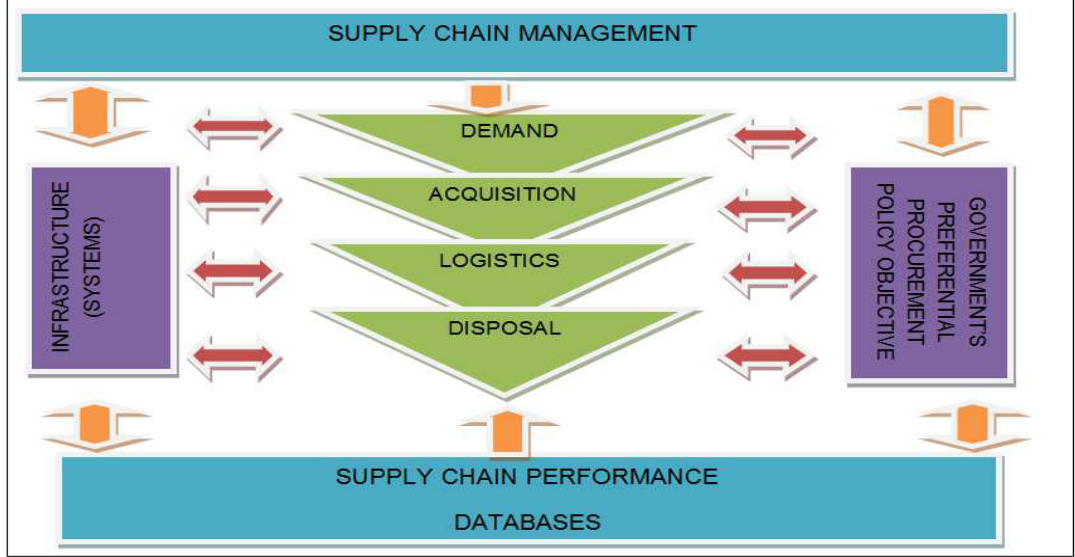
Fig. 1. Municipal SCM business